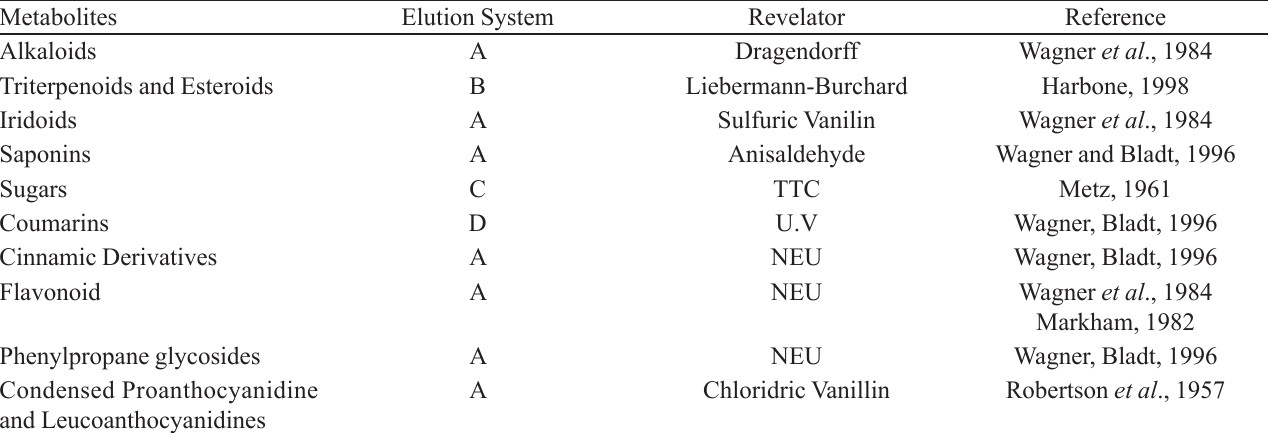
TABLE II - Chromatographic systems used for phytochemical screening of Caesalpinia pyramidalis Tull. Metabolites